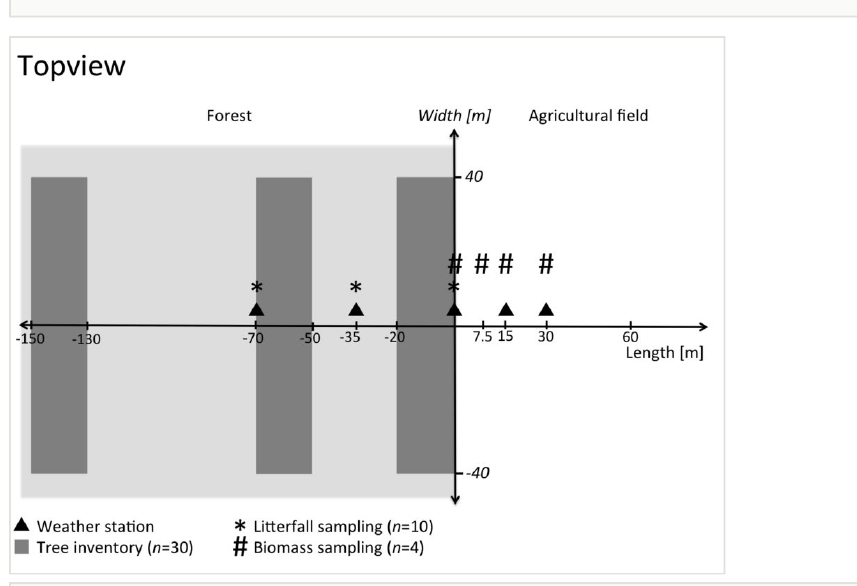
Figure 1. Cross-sectional scheme of the measurement design for both sites. The height for litterfall and biomass sampling is not scaled.